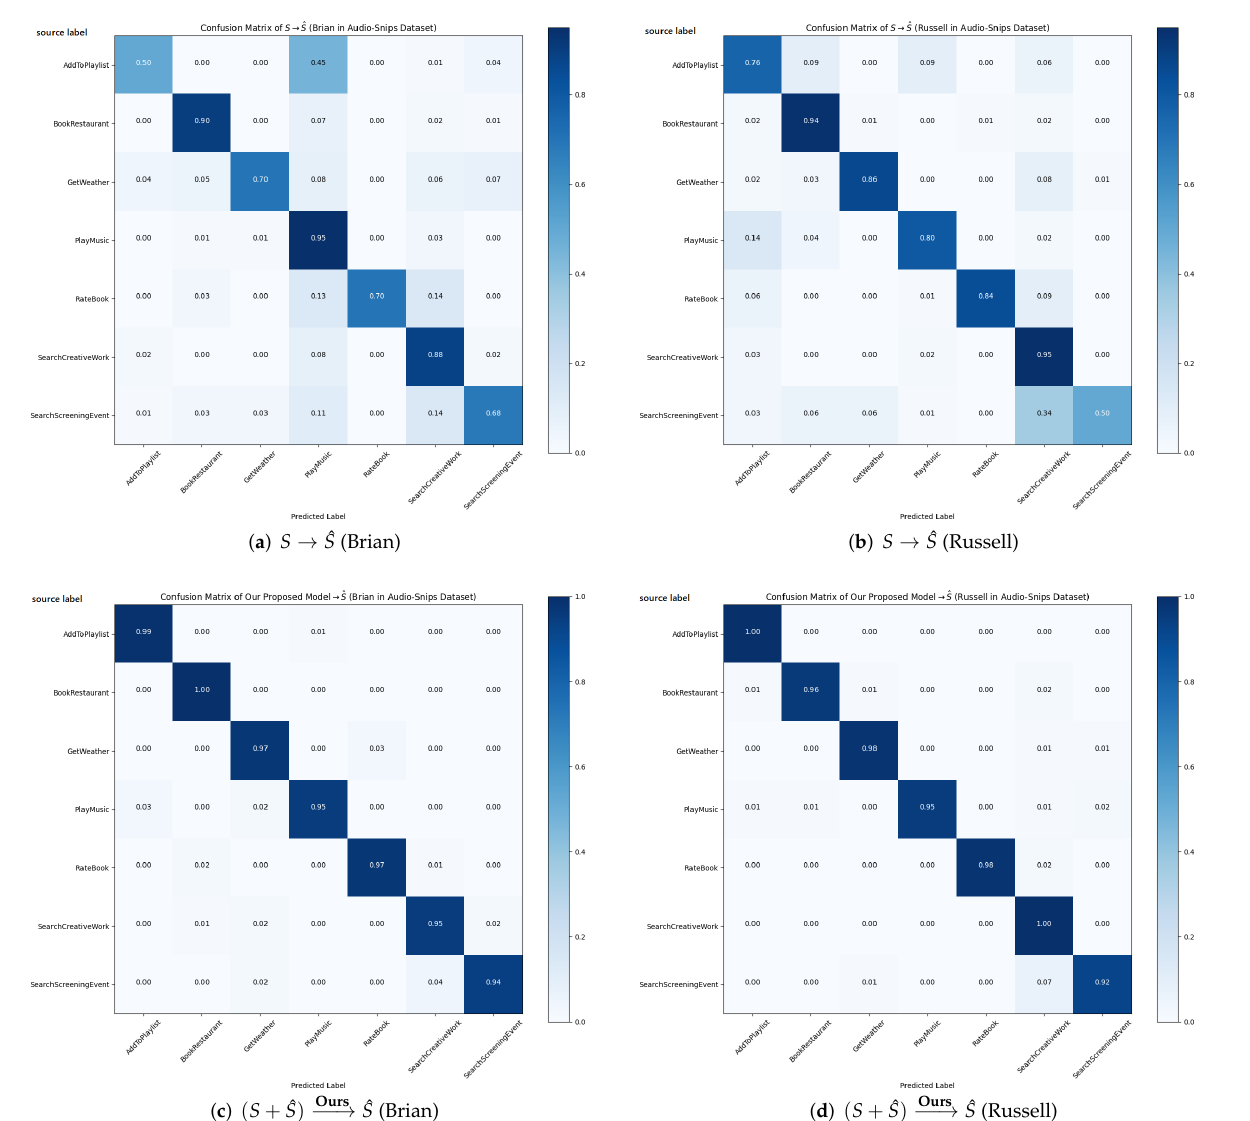
Figure 4. Confusion matrices of intent accuracy from Brian and Russell in the Audio-Snips dataset. ( a , b ) are S → ˆ S of Brian and Russell and ( c , d ) are their ( S + ˆ S ) Ours −−−→ ˆ S ,